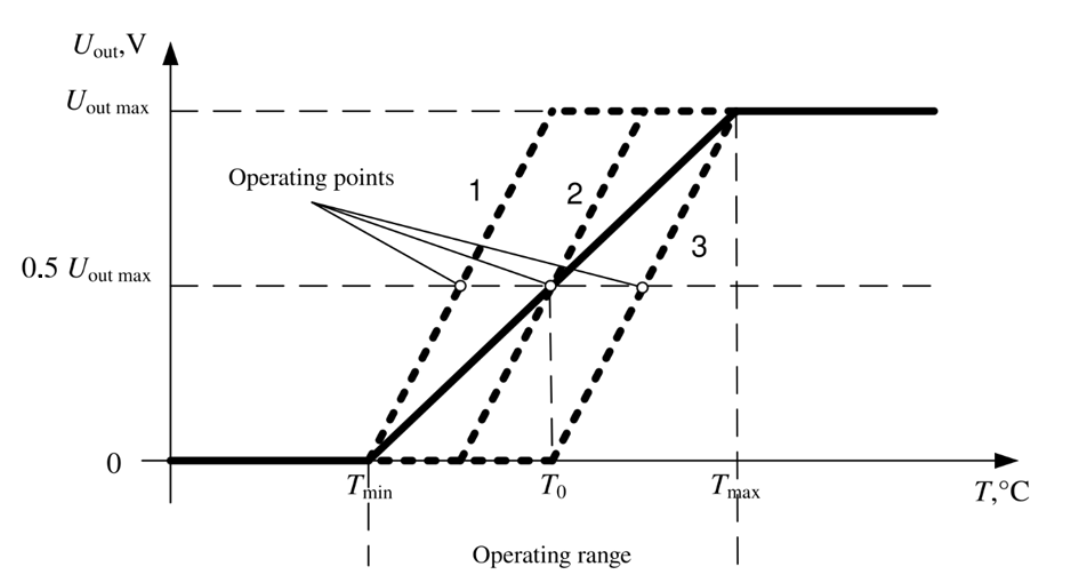
Figure 3. The output characteristic of the thermometer at the minimum (solid line) and the maximum gain (dashed line), curves 1, 2 and 3 are different variants of dependence in the operating range of the thermometer.